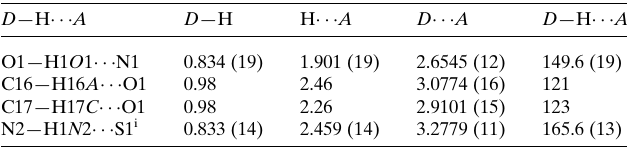
Table 1 Hydrogen-bond geometry (A˚ , (cid:2) ).